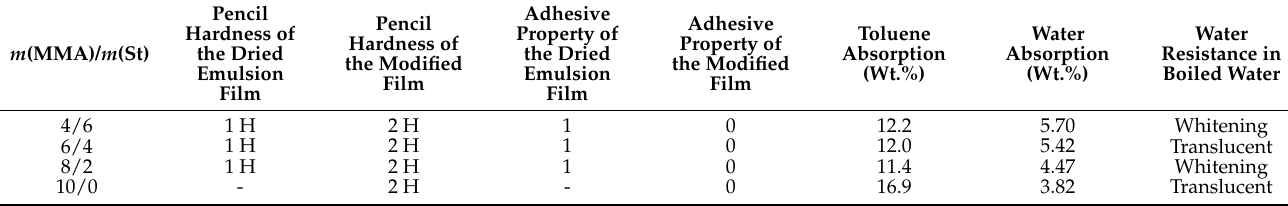
Table 2. Properties of the cured film synthesized by emulsion with St units in polymer